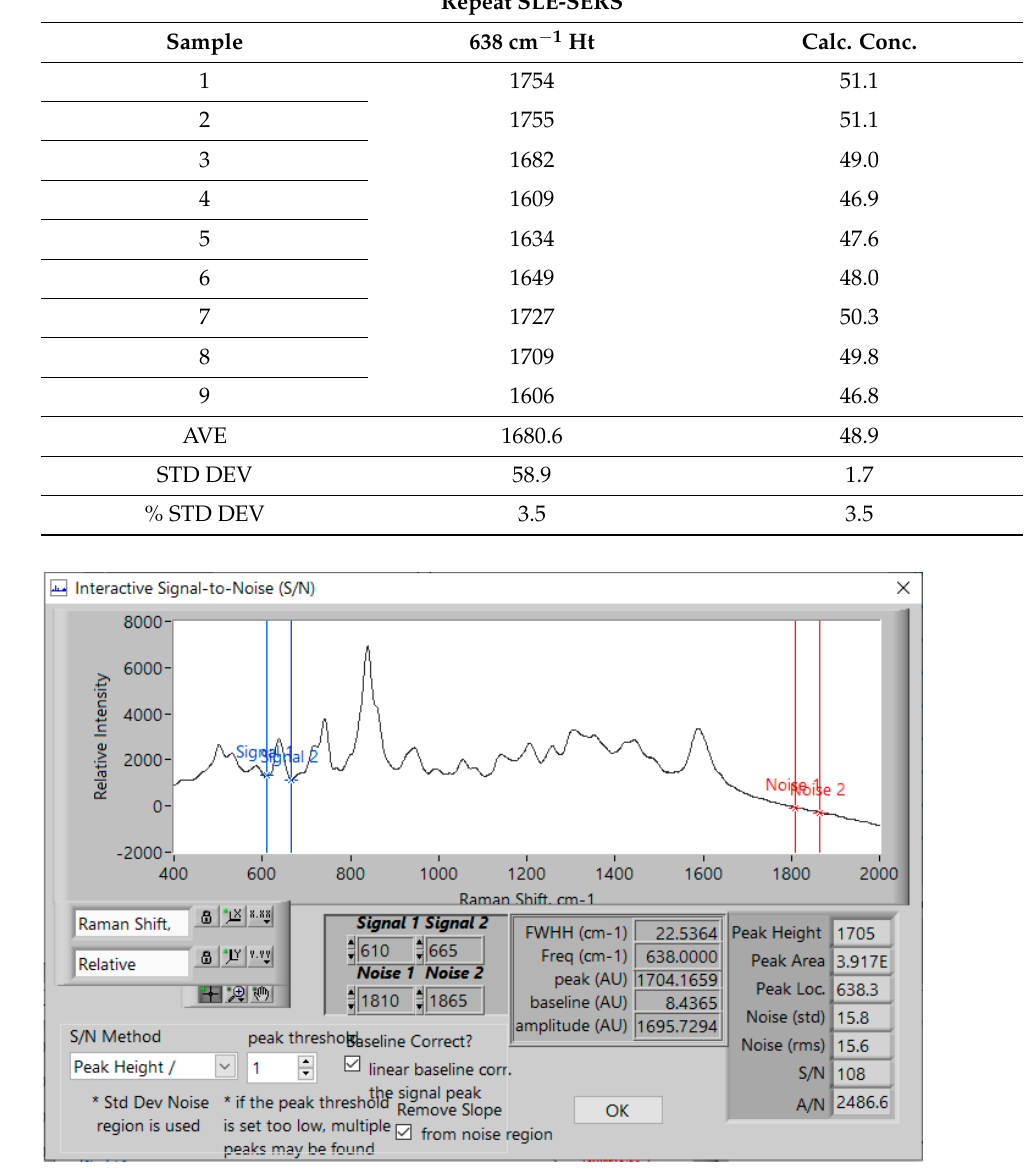
Figure 7. Image of Real-Time Analyzers’ S/N program used to calculate the S/N of 109 for 50 ng/mL and an LOD of 1.4 ng/mL and an LOQ of 4.6 ng/mL buprenorphine using the 638 cm − 1 peak and the rms noise between 1810 and 1865 cm − 1 . Conditions as in Figure 1.